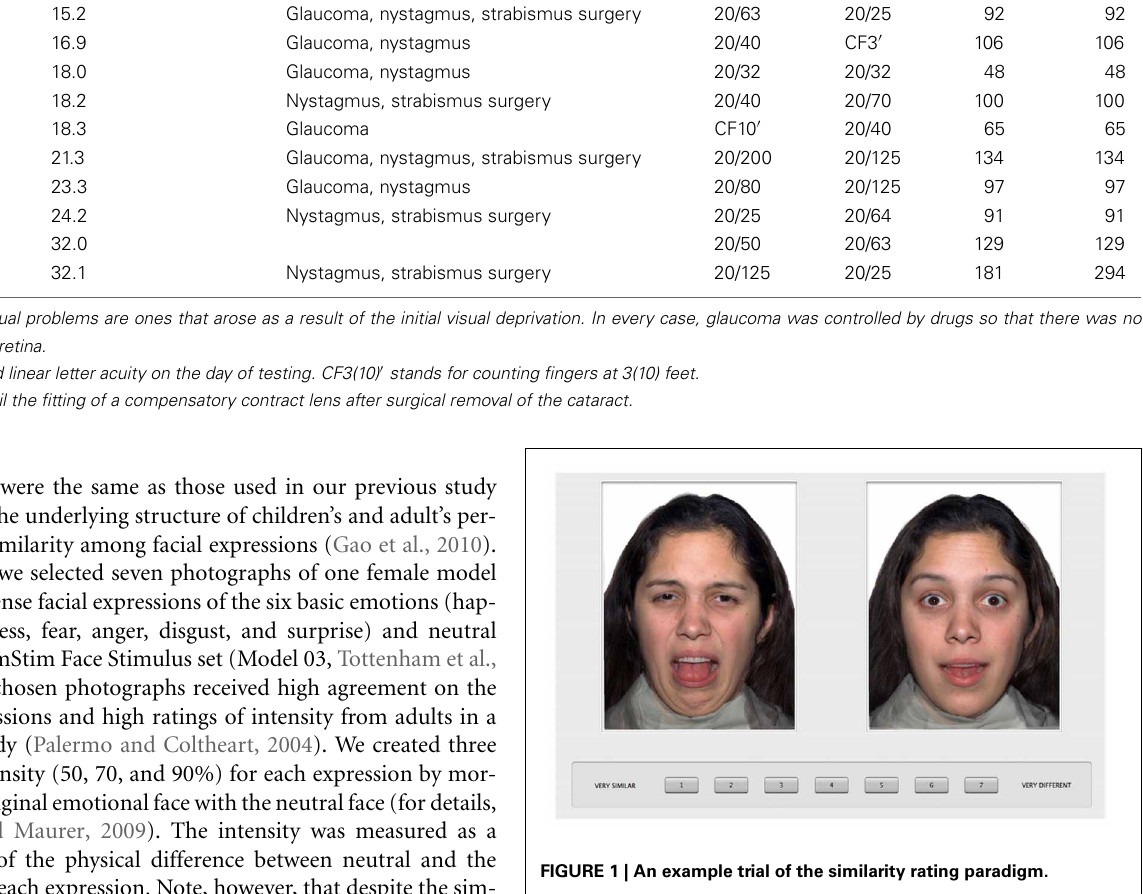
encouraged them to use the full range of the rating scale. In the testing session, each participant rated the similarity of all possi- ble pairs of the face images from the female model. On each trial, a pair of face images was displayed side by side on the computer screen (see Figure 1 for an example trial). There were a total of 171 pairs, which were displayed in a random order for each par- ticipant, and left/right position was also randomized within each pair. The task took about 20 min to complete, and was